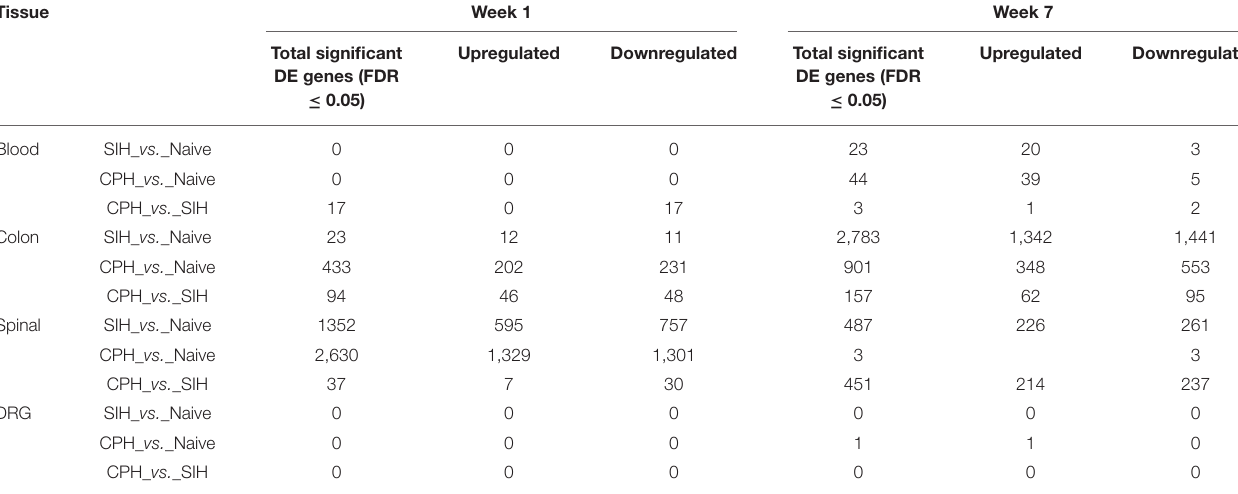
TABLE 2 | Differentially expressed genes across conditions and time elapsed from stress induction across all tissues. Tissue